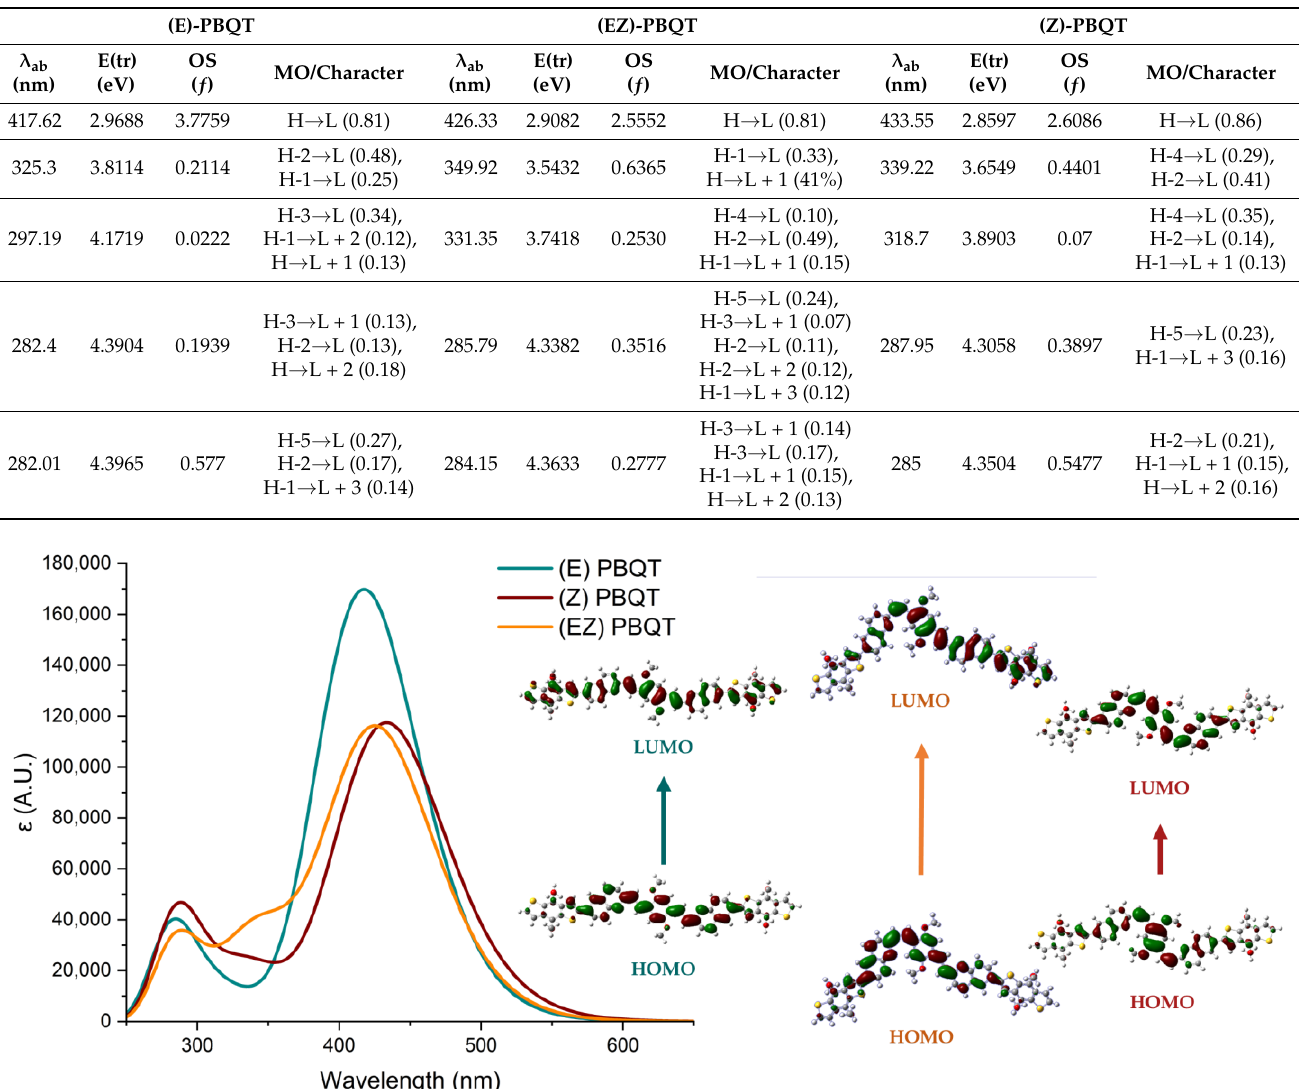
Figure 4. TDDFT absorption spectra of polymer PBQT obtained by applying BHandHLYP/6-31 (d, p) functional. At the right, Frontier molecular orbitals of PBQT in its cis ( (Z) PBQT ), trans ( (Z)-PBQT ), and intermediate ( (EZ) PBQT ) conformations.